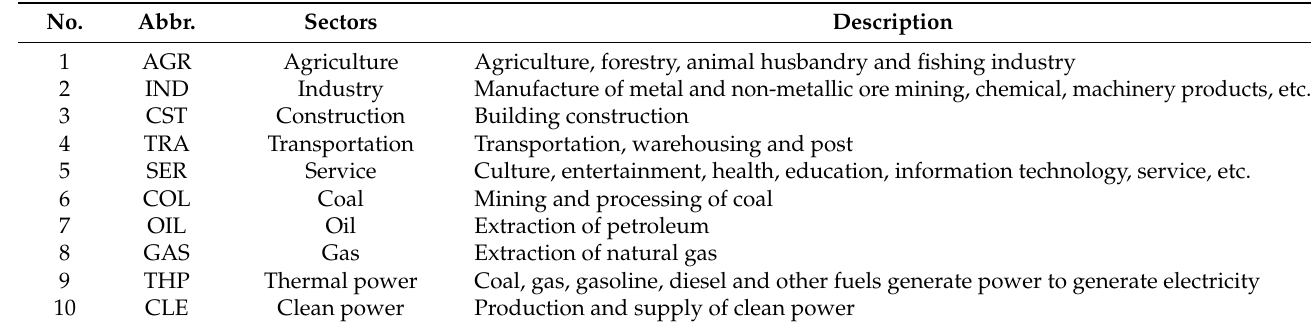
Table 1. Description of sector